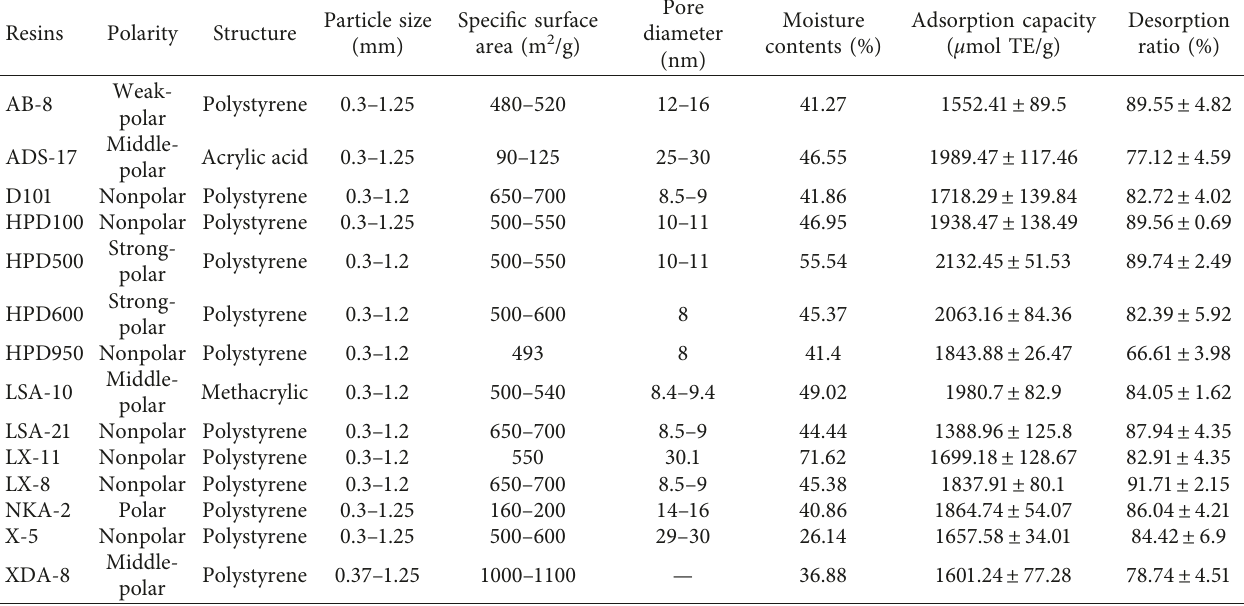
Table 1: Physicochemical properties and the static adsorption and desorption parameters of antioxidants on fourteen resins.